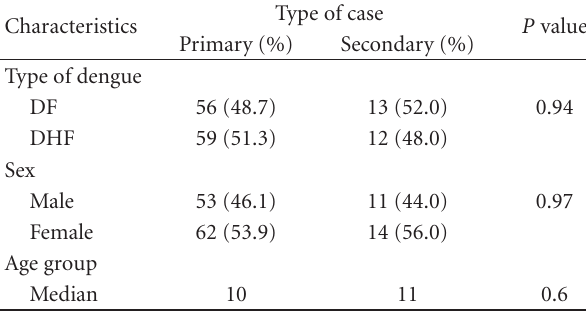
Table 1: General characteristics of DF/DHF